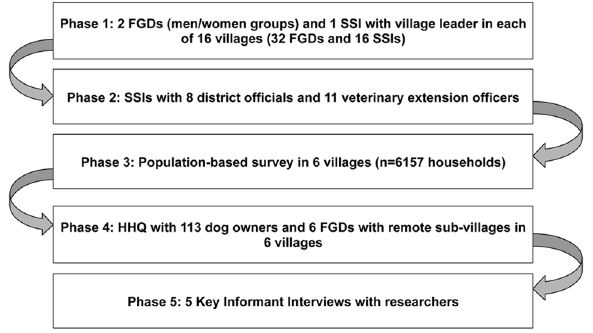
Figure 1. Study districts.